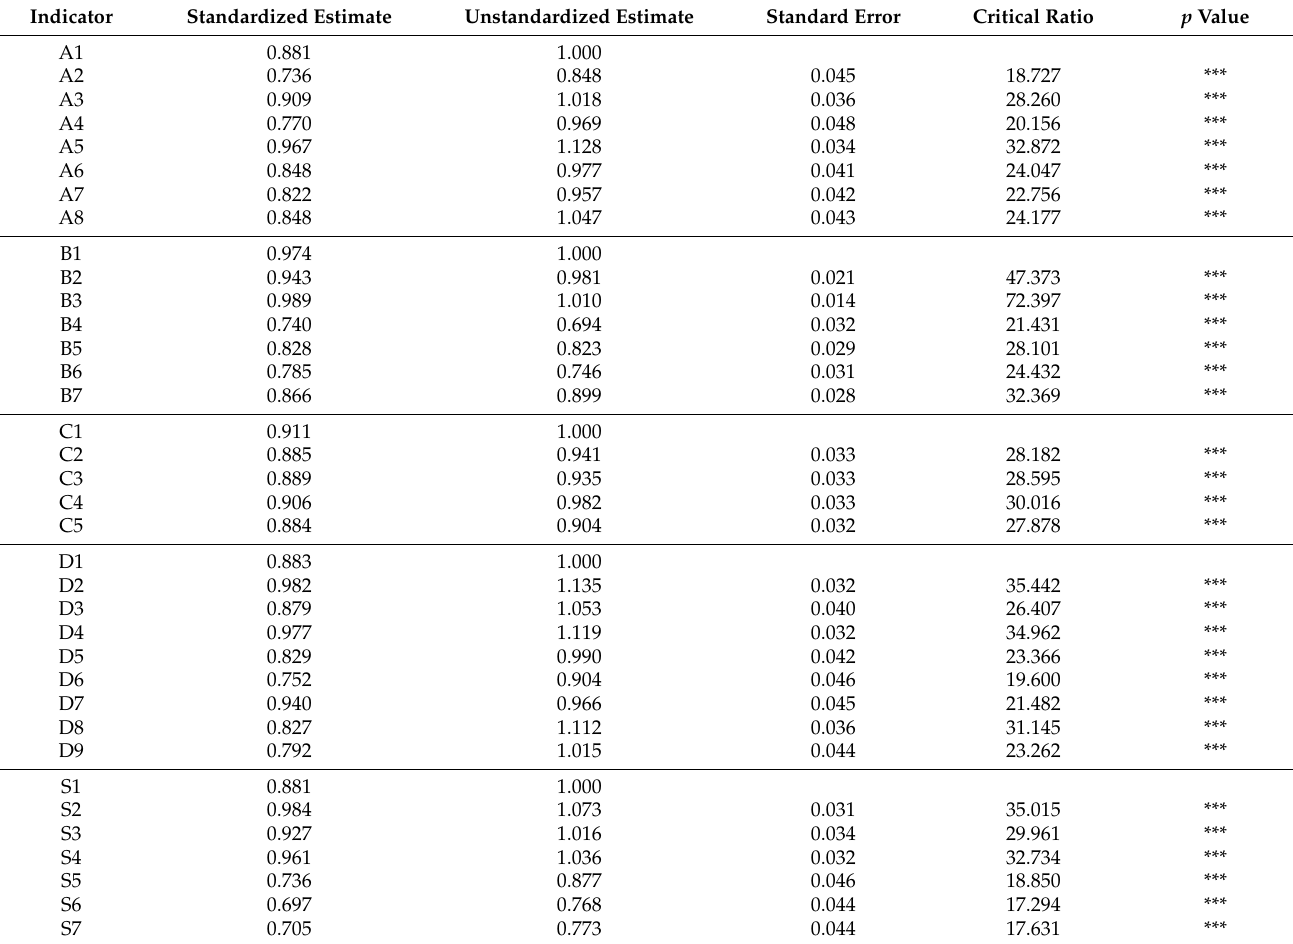
Table 7. Estimates of the CFA